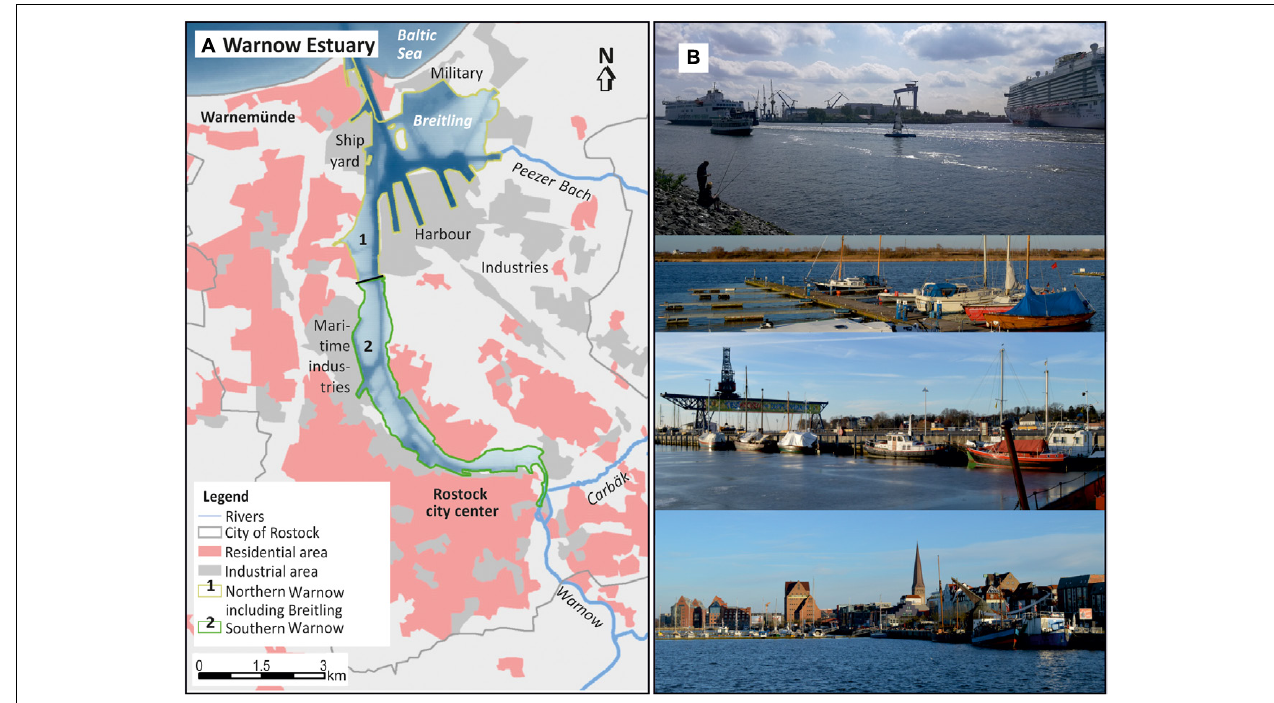
FIGURE 2 | (A) Basic geographical information about the industrial, urban Warnow Estuary and the boundary between northern, industrial and southern, urban Warnow water body, (B) the overseas harbor, a sport boat harbor, the city harbor and the city center of